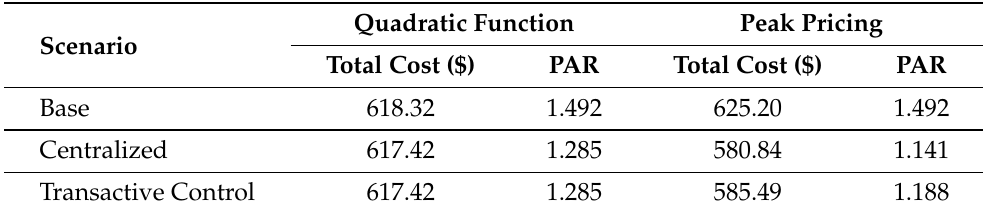
Table 3. Solution of each scenario: community’s total cost and peak-to-average ratio of the group’s final load